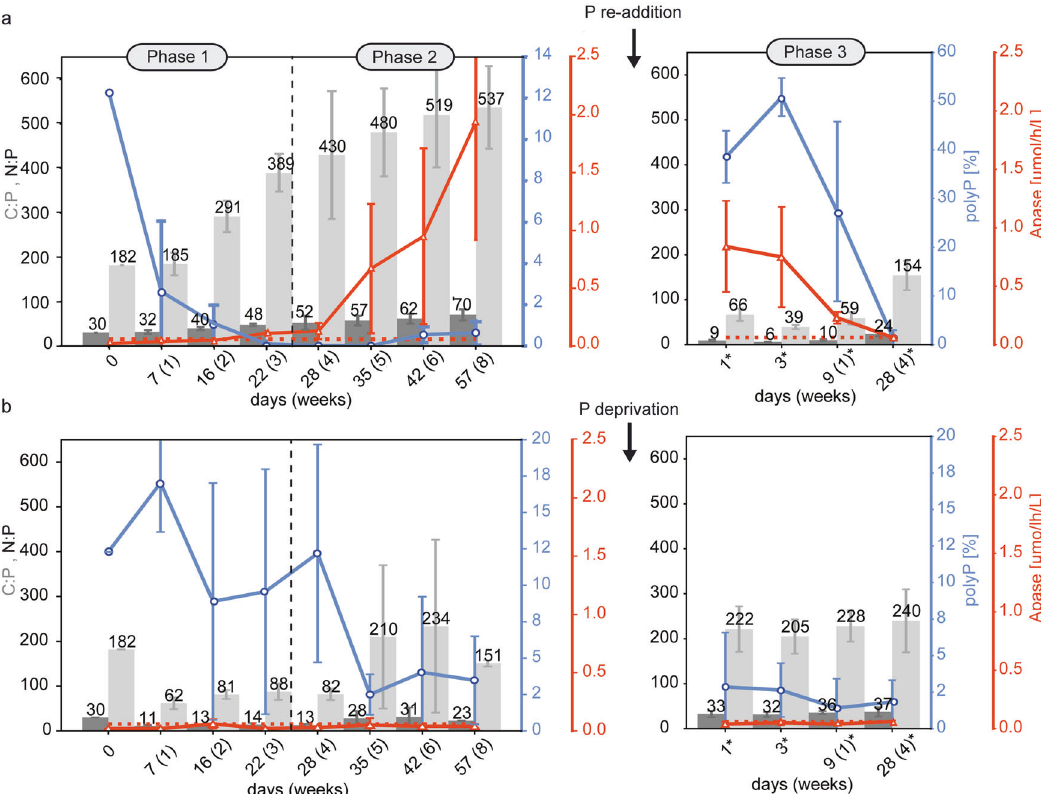
Fig. 2 Cellular C:N:P ratio, polyphosphate (polyP) accumulation and alkaline phosphatase (APase) activity at different bio fi lm development phases during the 12 weeks experiment. Numbers marked by a star symbol in Phase 3 indicate days after ( a ) P re-addition in the low P experiment or ( b ) P-deprivation in the high P control experiment at day 57. The red dashed line indicates the threshold of elevated APase activity. Error bars display the standard deviation of triplicates.